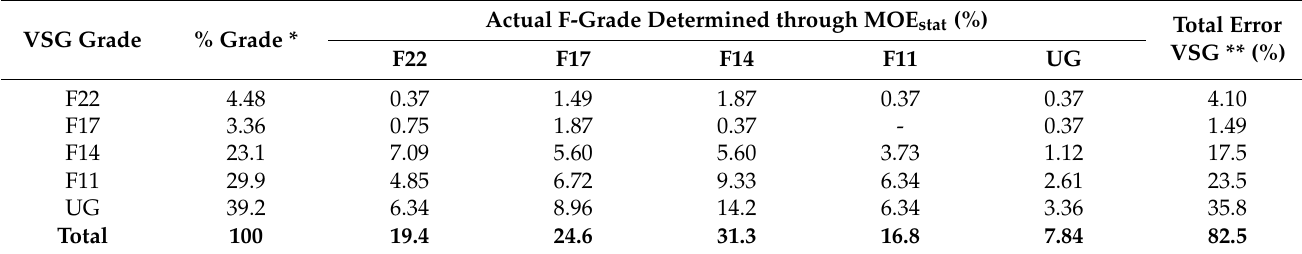
Table 4. Classification of boards via the visual stress grading (VSG) method and relative error. Grades are ordered from the highest grade (F22) to the lowest (F11) following the Australian Standard for E. nitens . UG: boards that are under-grade, with MOE stat lower than the lowest limit in the Australian Standard for E. nitens